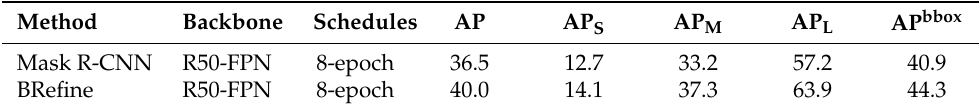
Table 8. Results on the Cityscapes validation set. All models were trained on an 8-epoch training schedule.